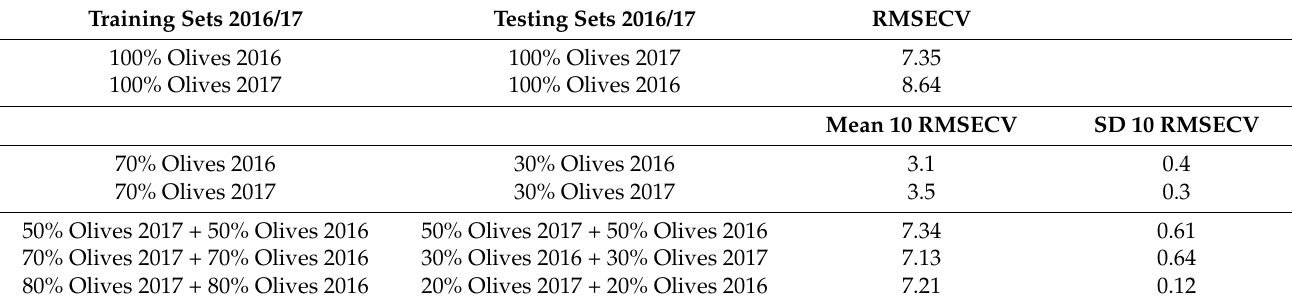
Table 1. RMSECV of EM of OC of individual olives based on clustering by similar color and NIR in different training and testing sets with olives from the 2016 and/or 2017 seasons.